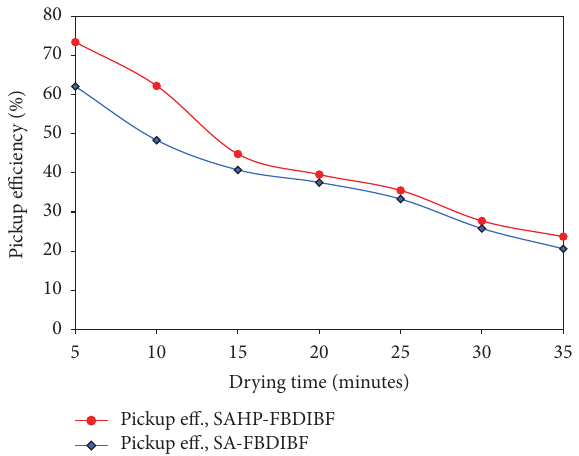
Figure 23: The variation of pickup efficiency with drying